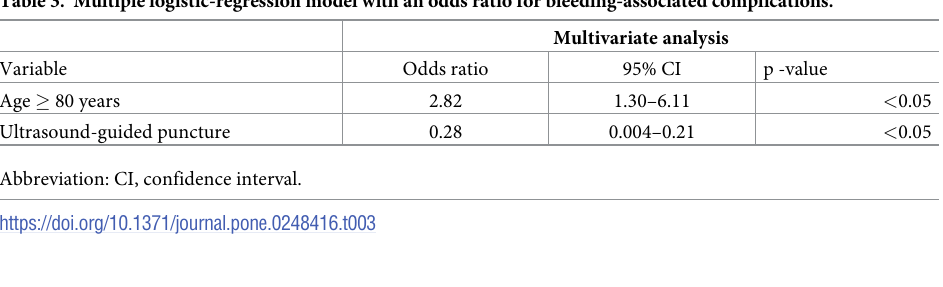
Table 3. Multiple logistic-regression model with an odds ratio for bleeding-associated complications.